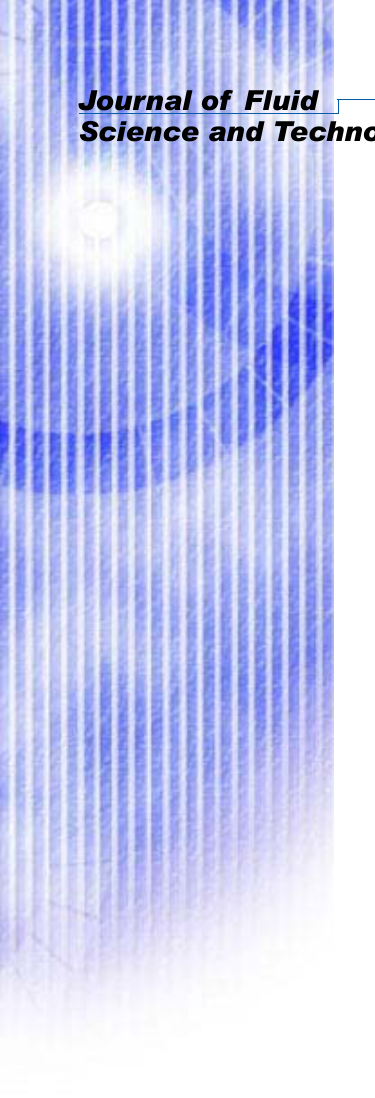
Figure 4 The comparisons of velocity and temperature profiles for various wall temperature distributions (n=-1/3, 0, 1/3, 1) with M=2 and φ =60° at ξ =5.